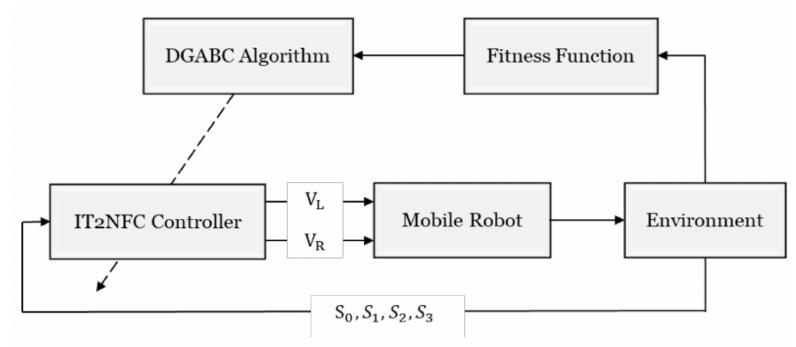
Figure 8. Flowchart of wall-following control learning.